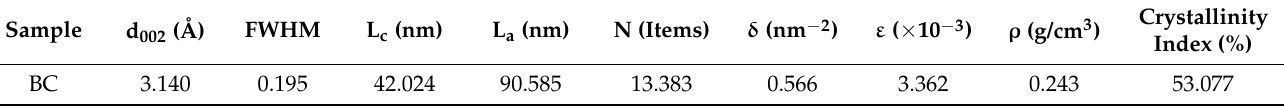
Table 4. Structural information of BC, as determined from XRD